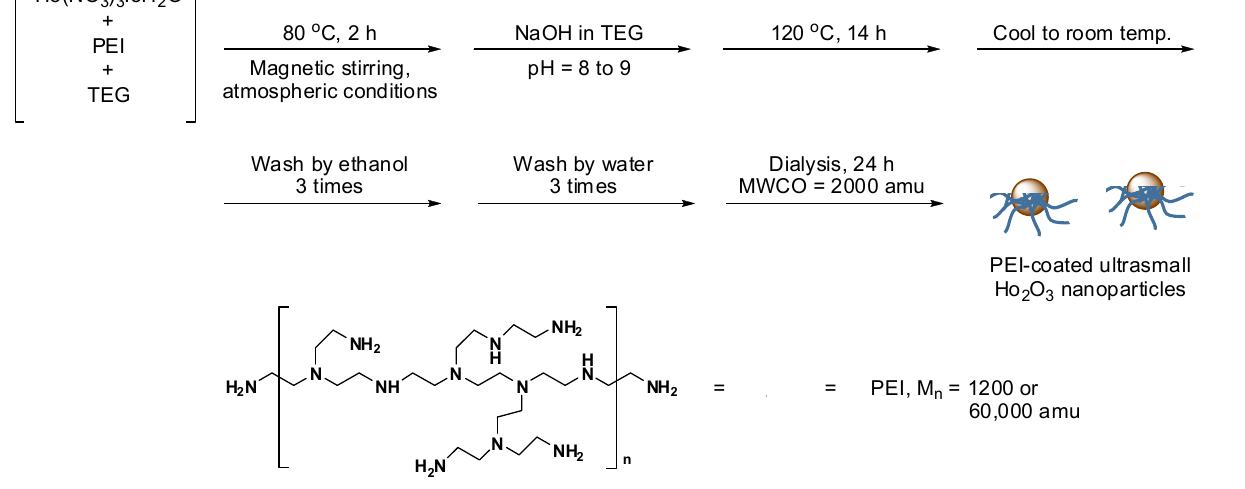
Figure 1. One-pot polyol synthesis of ultrasmall Ho 2 O 3 nanoparticles coated with PEI1200 and PEI60000 (M n = 1200 and 60,000 amu, respectively).